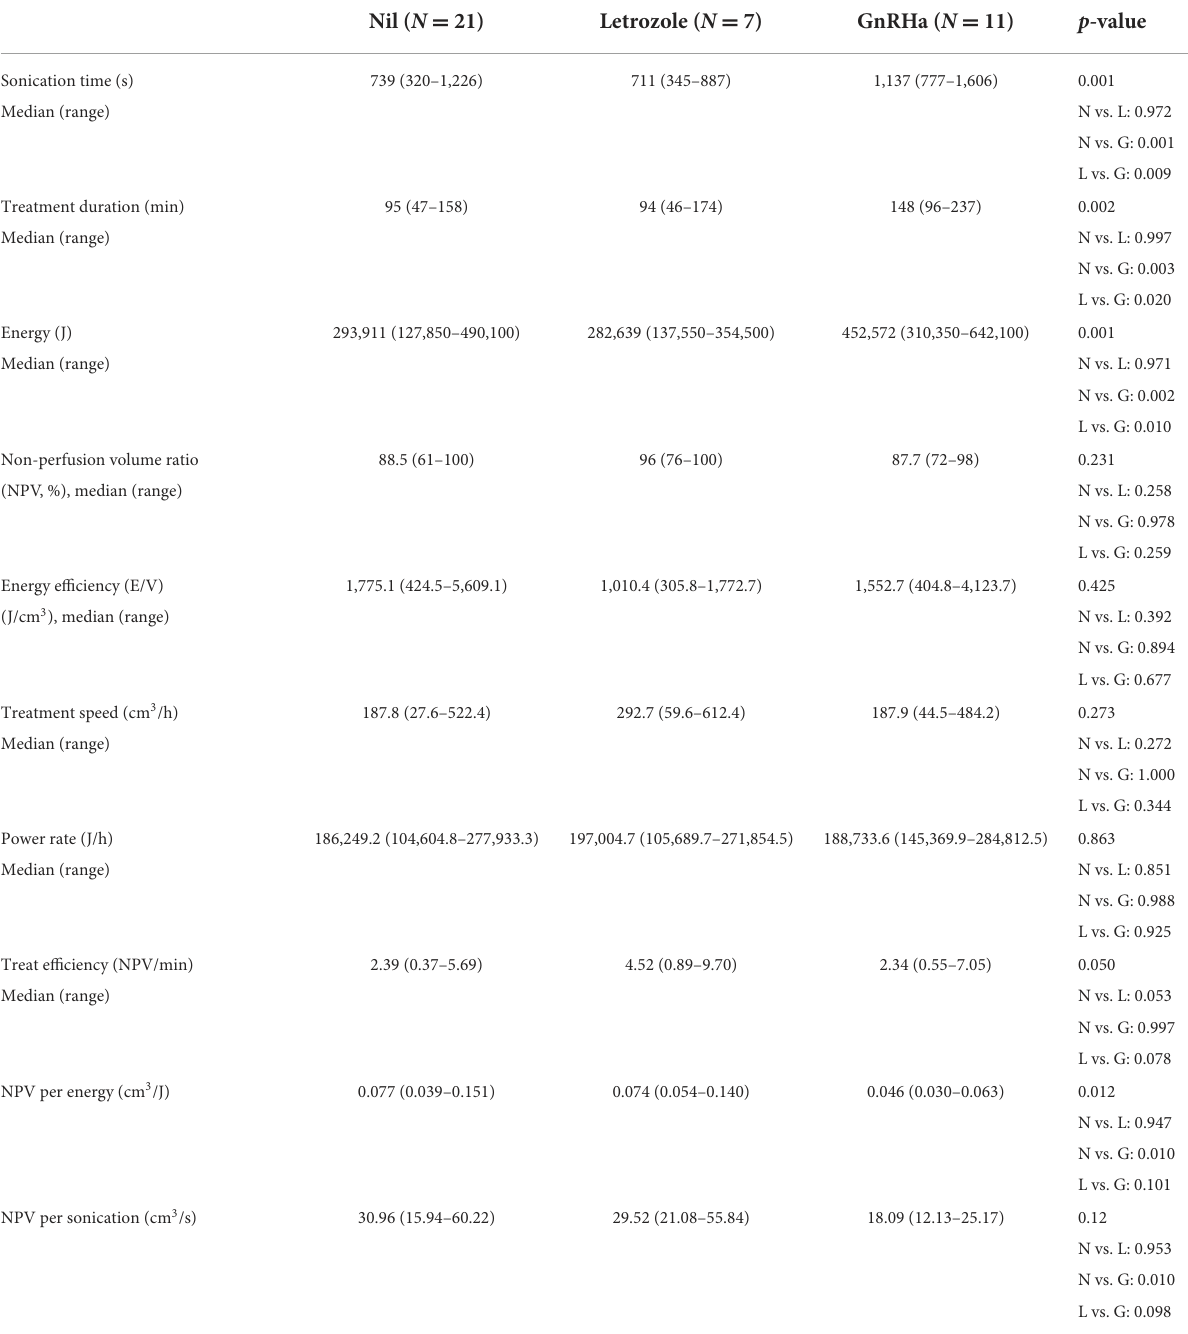
TABLE 3 HIFU treatment